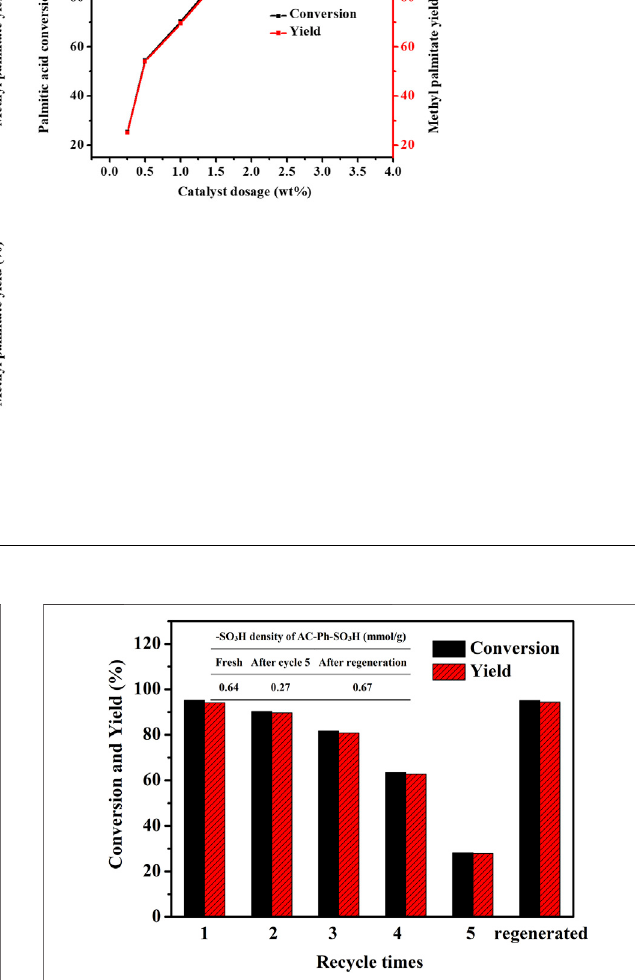
FIGURE 8 | Conversion of palmitic acid catalyzed by AC-Ph-SO 3 H and its precursors. FIGURE 9 | Recycle performance of AC-Ph-SO 3 H on methylation of